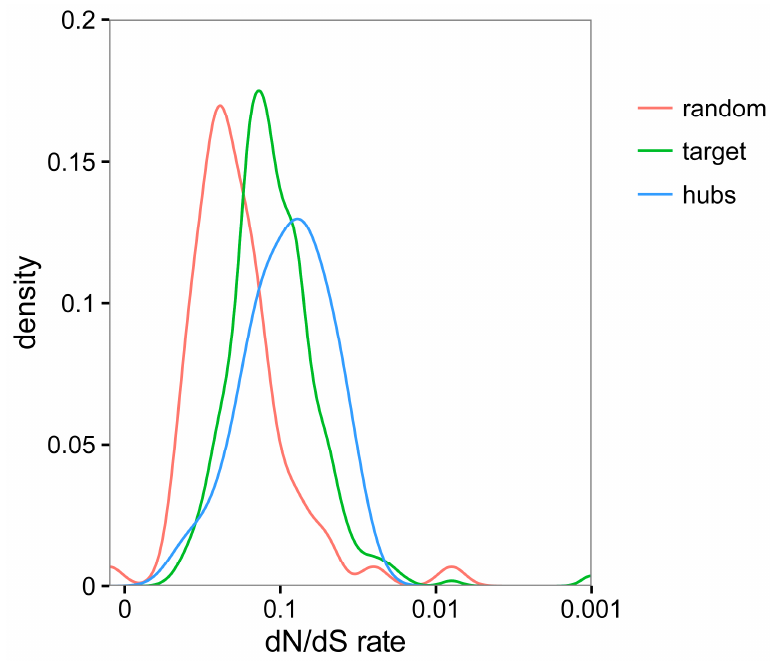
Figure 6. Comparative analysis of evolutionary rates (non-synonymous versus synonymous changes—dN/dS) between all TYLCV-interacting proteins (referred to as target; depicted in green), TYLCV-targeted hub proteins (depicted in blue), or randomly selected proteins from N. benthamiana (depicted in red) and the orthologous proteins in potato ( Solanum tuberosum ).